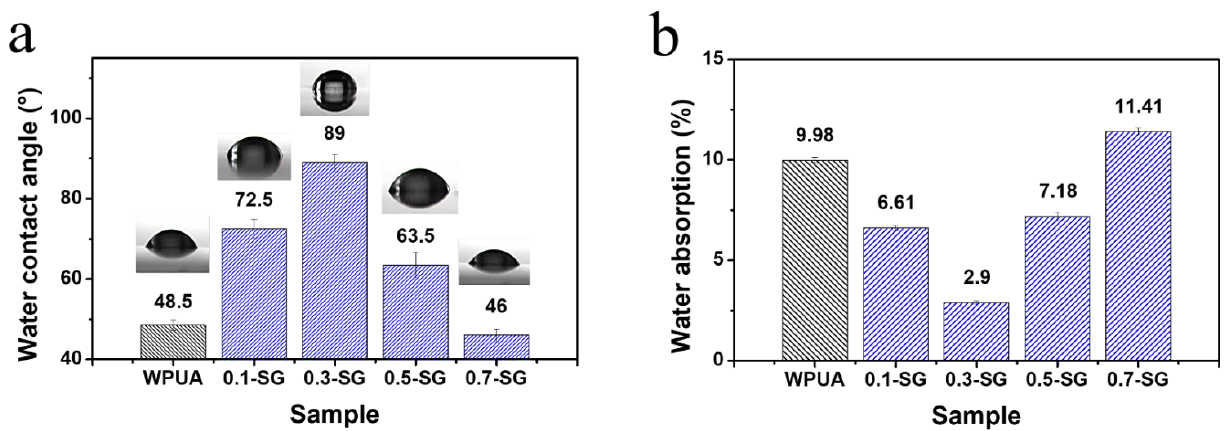
Figure 6. Water contact angle ( a ) and water absorption capacity ( b ) of different composite films. The micrograph of 0.3-SG with the best water resistance and WPUA was selected for observation. From Figure 7a,c, the WPUA and 0.3-SG all showed black micro-cracks,